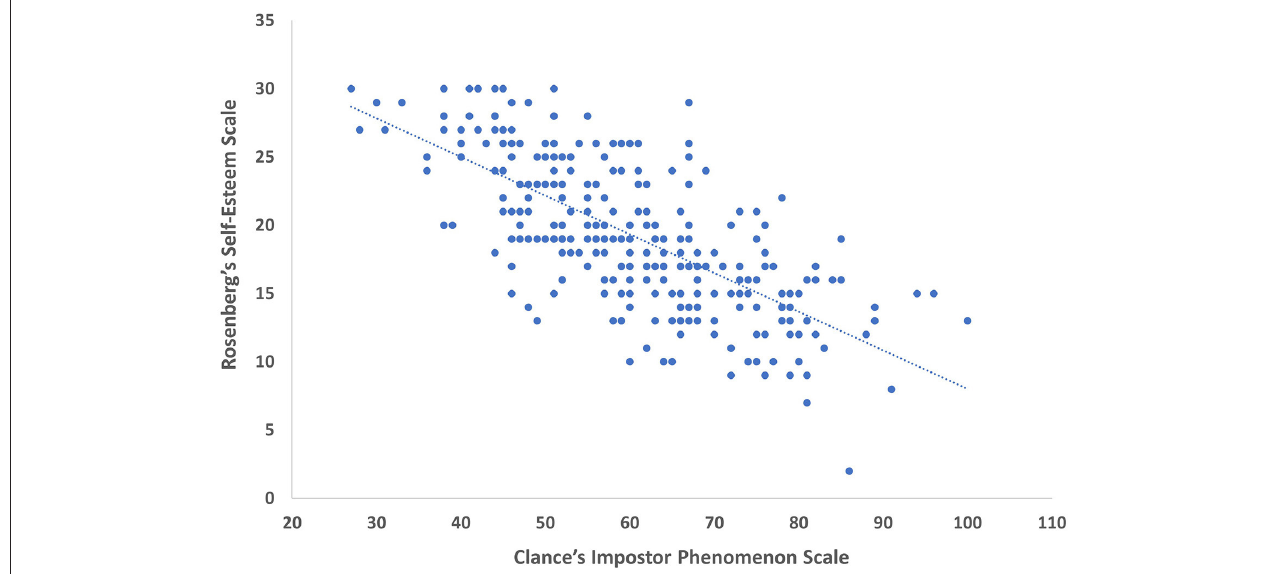
FIGURE 1 | Correlation between student scores for clance impostor phenomenon scale and Rosenberg Self-Esteem